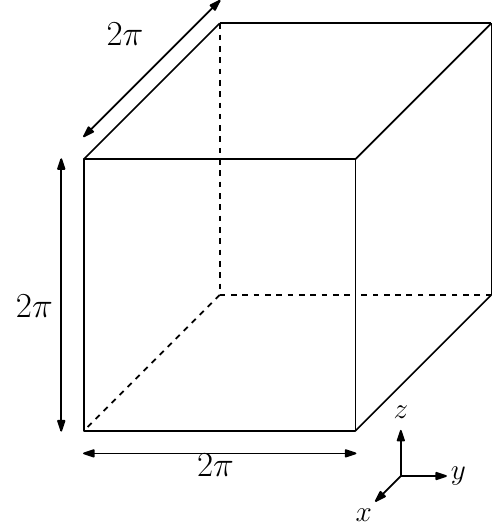
Figure 1. Geometry of the outer computational